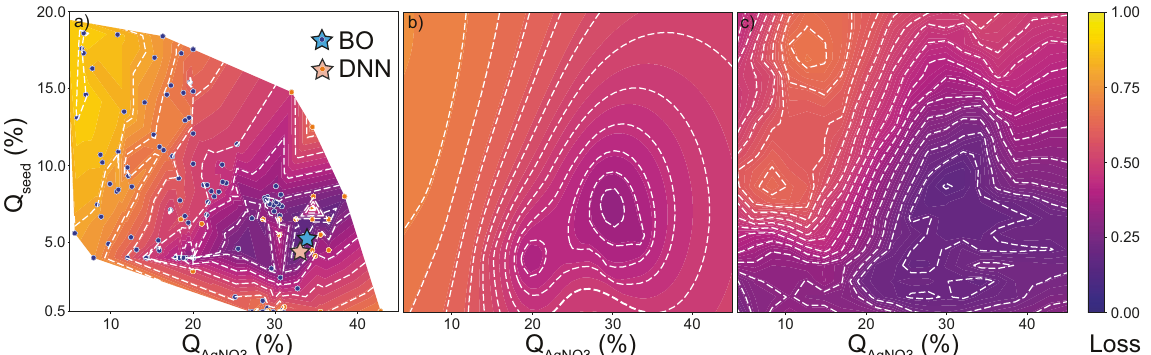
Fig. 3 Interpretability of the algorithmic decision process. 2D mapping of the minimum loss obtained with ( a ) the raw experimental data, , Q seed } space. Experimental conditions are represented by blue disks (BO suggested ( b ) the BO, and ( c ) the DNN regression in the { Q AgNO 3 conditions from run 1 to 8) and orange disks (DNN suggested conditions from run 6 to 8). Stars represent the parameter conditions for the best loss performance obtained by the BO and the DNN. The colours correspond to the loss values as indicated on the colour